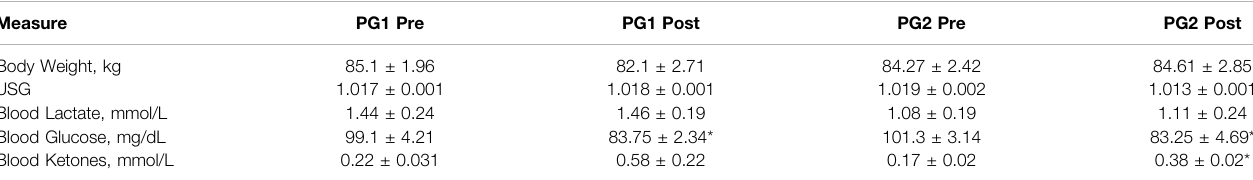
TABLE 2 | Physiological dive data.